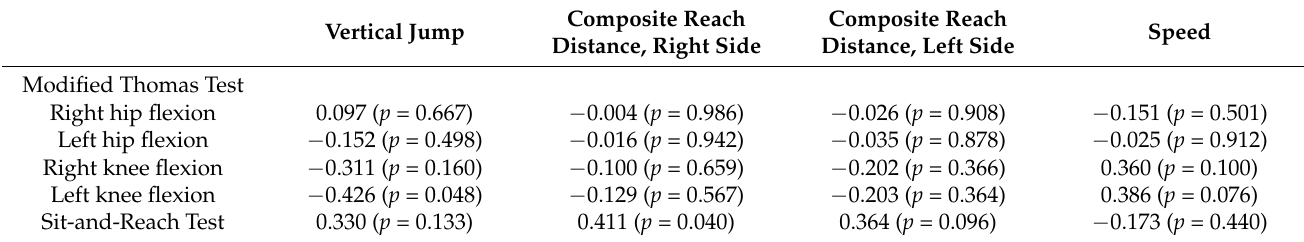
Table 5. Correlation coefficients between data on flexibility tests and data on vertical jump balance and speed tests a